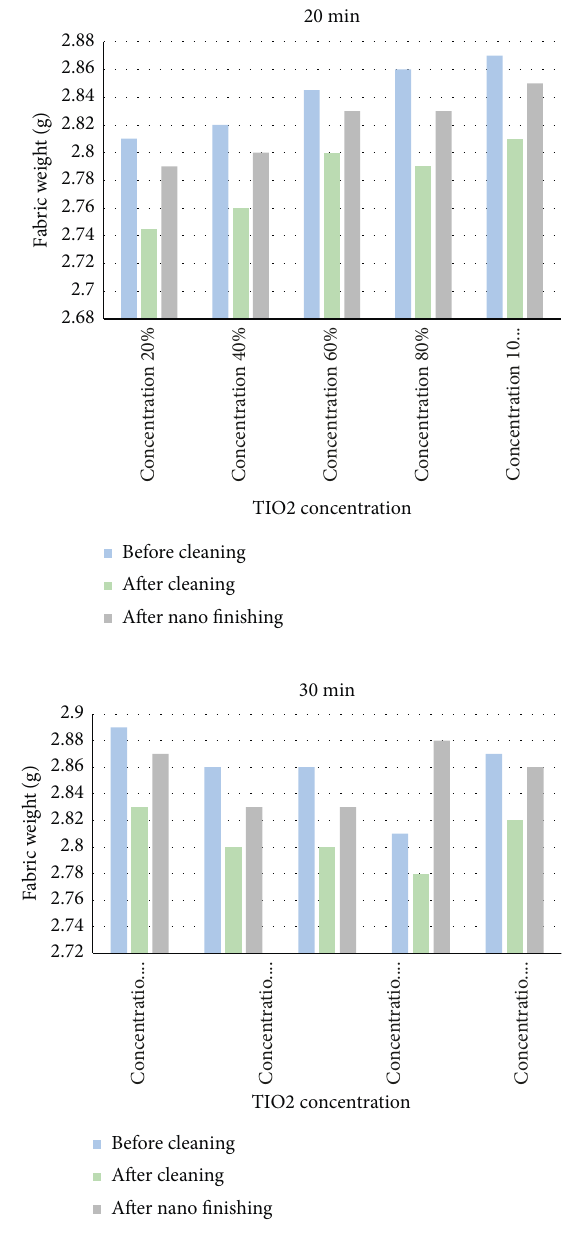
Figure 6: Weight change of cotton fabric under different times of ultrasonic